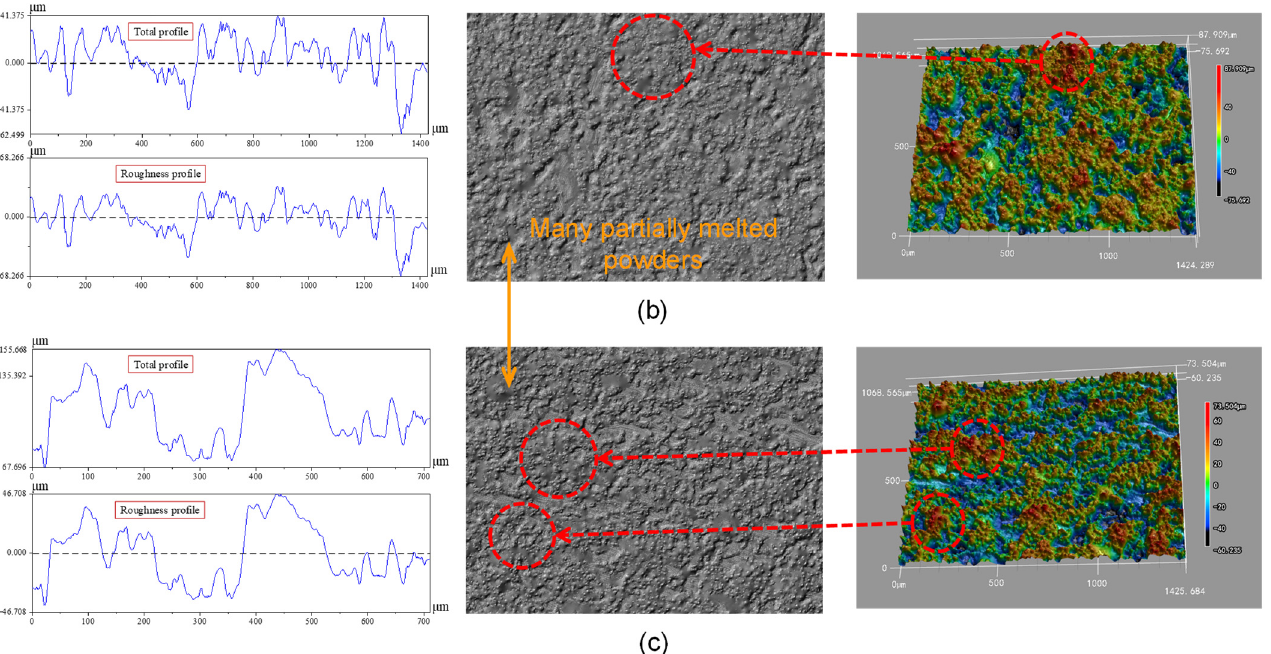
Figure 11. Surface profile, microscopic images and 3D surface analysis of Ti6Al4V fabricated by SLM. ( a ) SLM-VB; ( b ) SLM-PB-S; ( c ) SLM-PB-L.